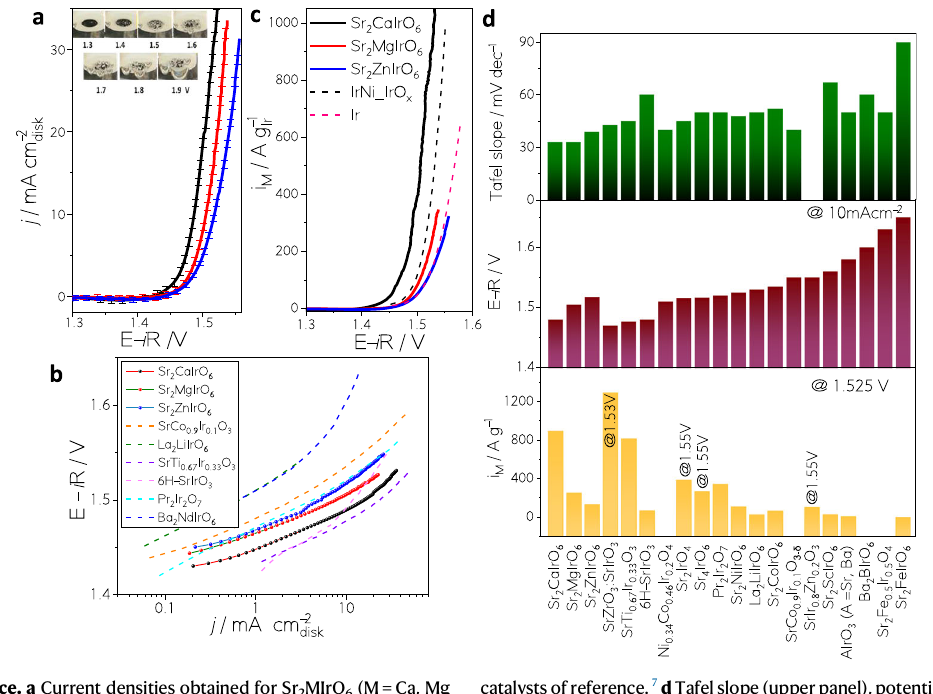
catalystsofreference. 7 d Tafelslope(upperpanel),potentialat10mAcm − 2 (middle panel) and Ir mass-speci fi c activity at 1.525V (bottom panel) of the state-of-the-art OER Ir-mixed oxide catalysts reported in the literature (appropriate references are given in Table